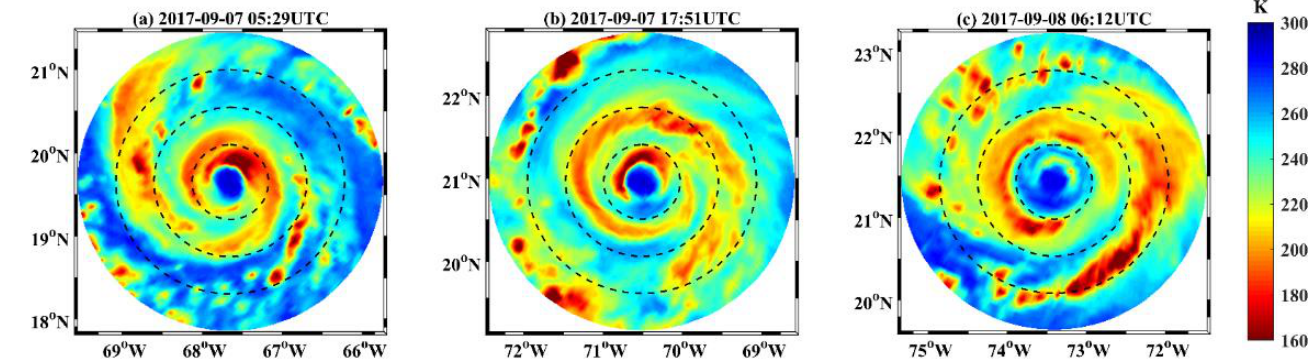
Figure 13. Storm-centered 85-GHz AMSR-2 imagery of brightness temperature over Irma at ( a ) 05:29 UTC on 7 September, ( b ) 17:51 UTC on 7 September, and ( c ) 06:12 UTC on 8 September. The color bar (unit: K) denotes brightness temperature in the Irma’s inner core. The black dashed circles represent radial rings spaced in 50 km increments.